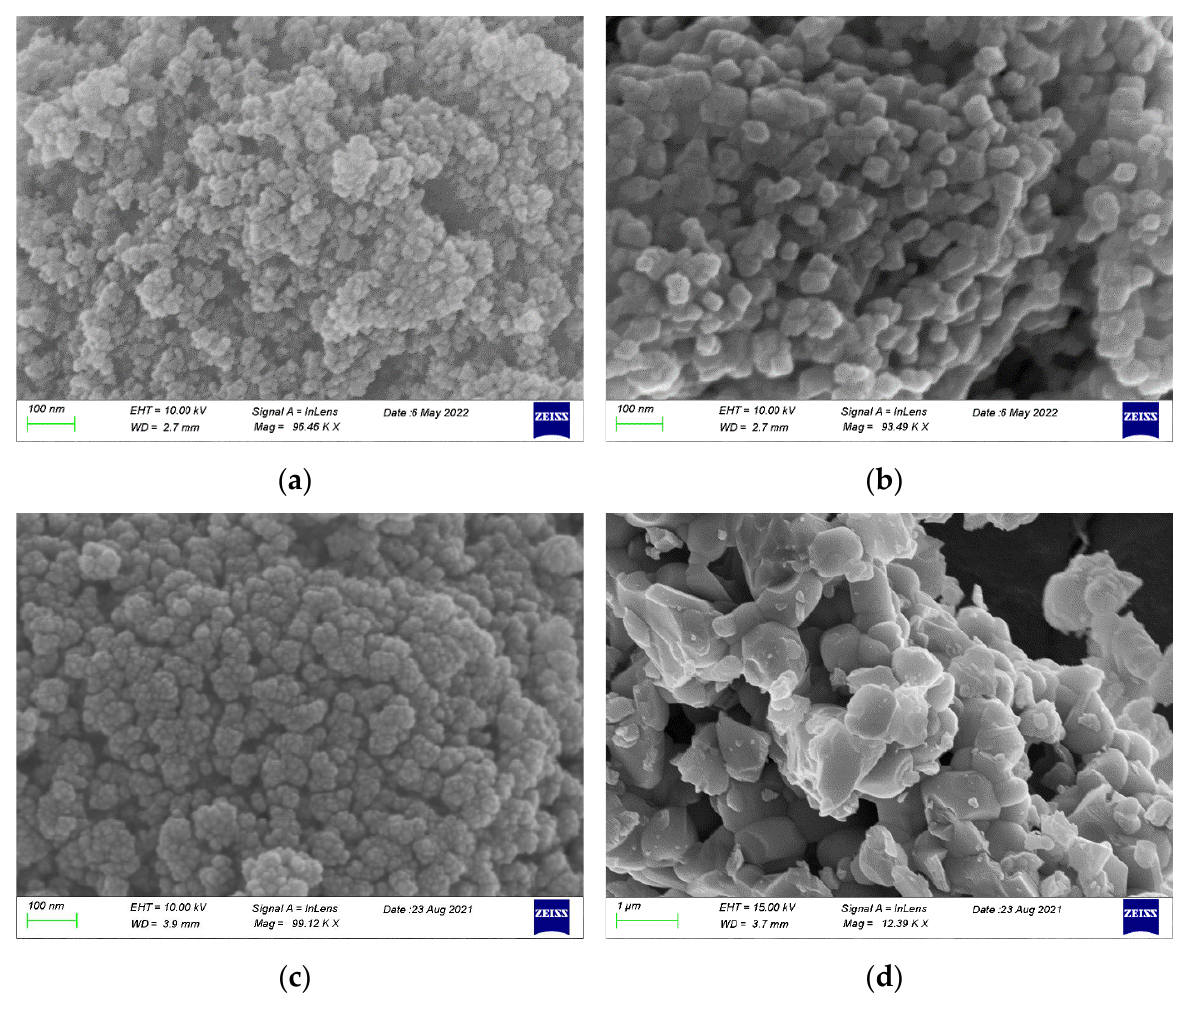
Figure 6. Scanning electron microscopy images of CZ-fresh ( a ) and -aged ( b ) and PROM100-fresh ( c ) and -aged ( d ).